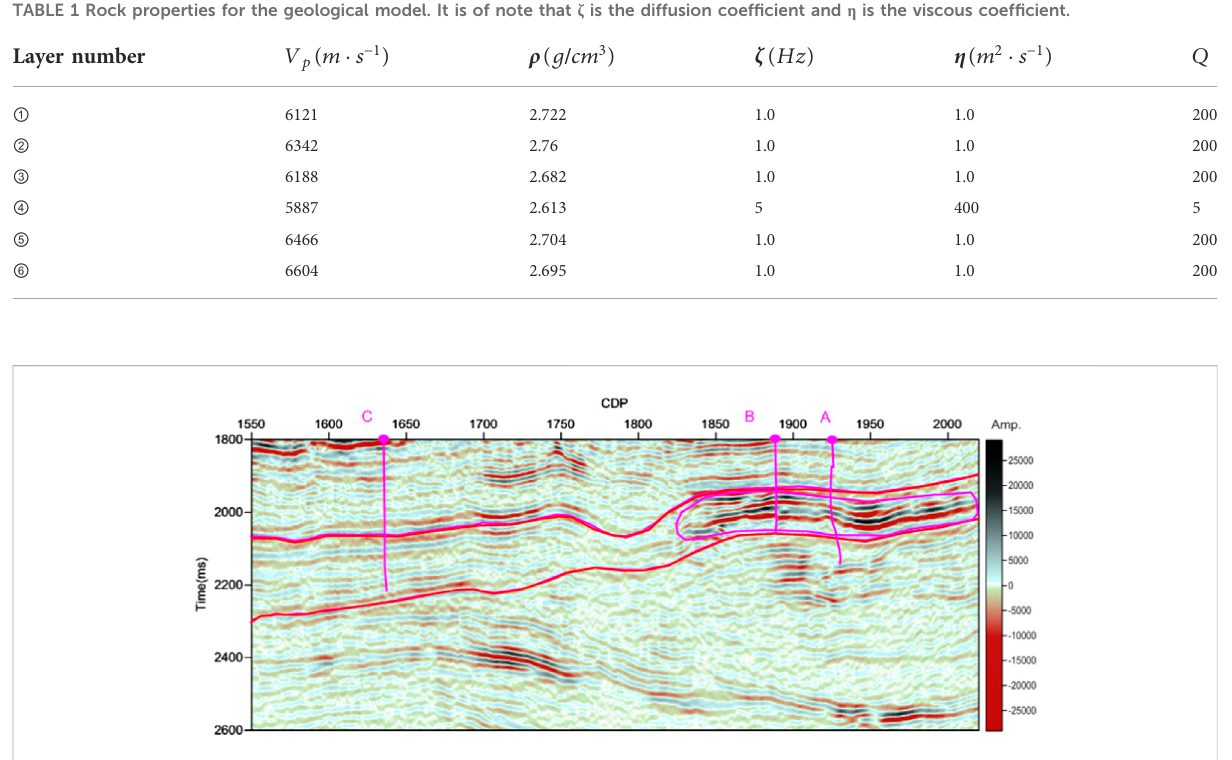
FIGURE 2 The seismic section intersecting three known wells, named A – C , respectively, from the Pugang gas fi eld,